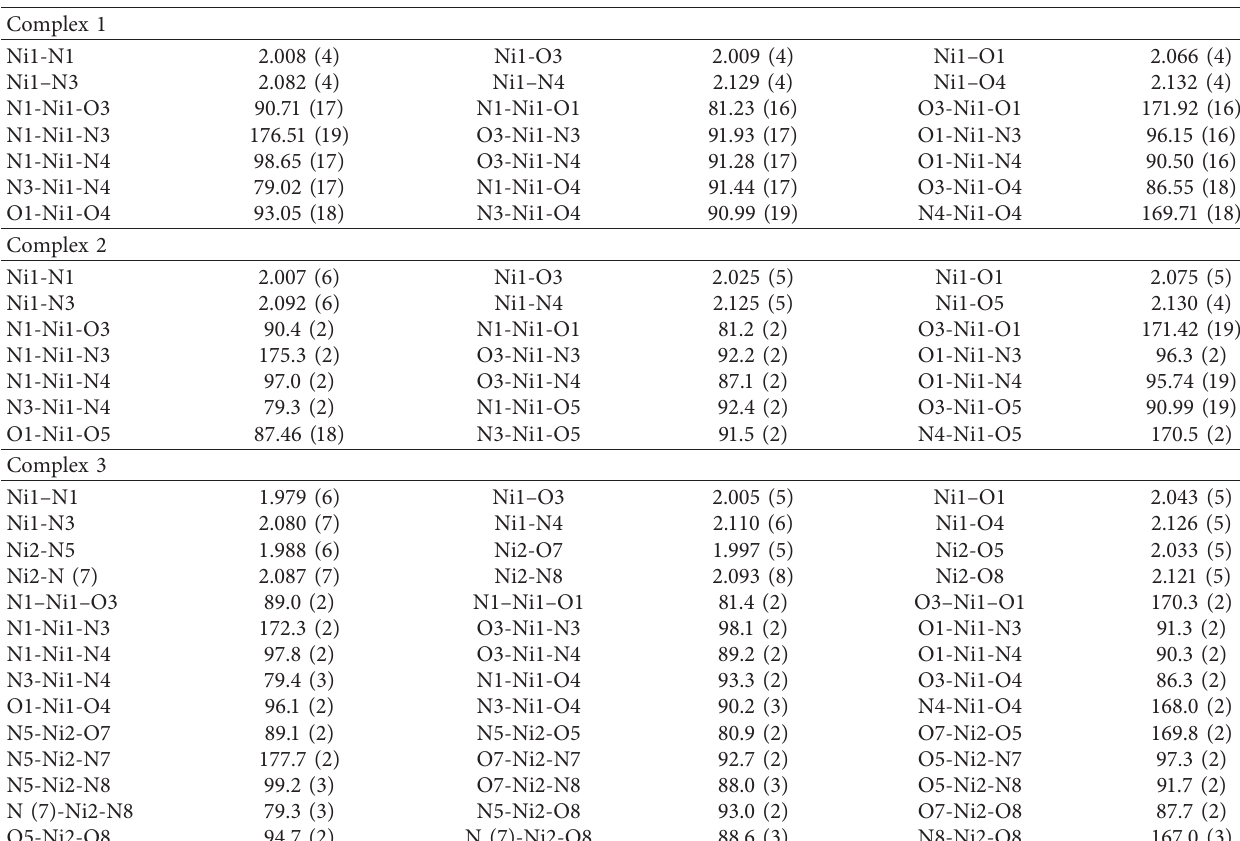
Table 1: Selected bond lengths (˚A) and bond angles ( ° ) for complexes 1, 2, and